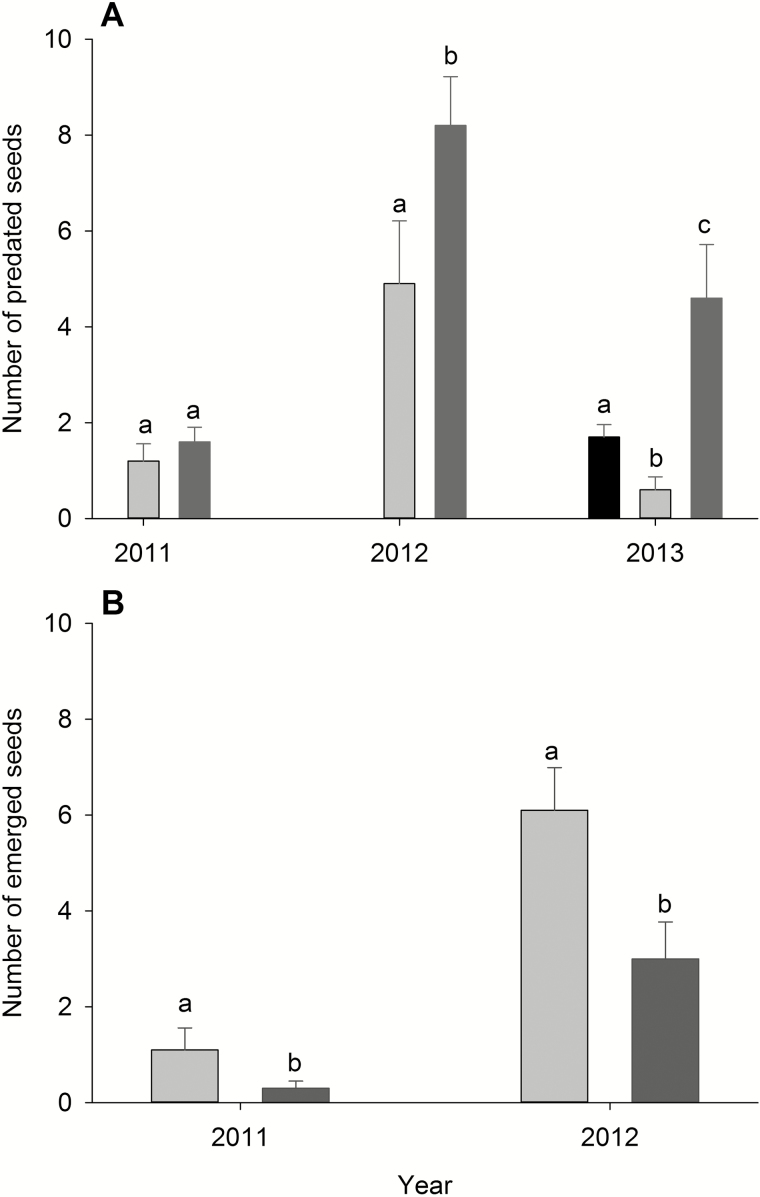
(A) Number of predated seeds after 3 weeks in: open interspaces (black), under conspecific shrubs (dark grey) and rock cavities (light grey). (B) Number of emerged seedlings after 6 months under conspecific shrubs (dark grey) and rock cavities (light grey). For both panels, lowercase letters indicate differences among groups within a single year. Means ± 1 SE.